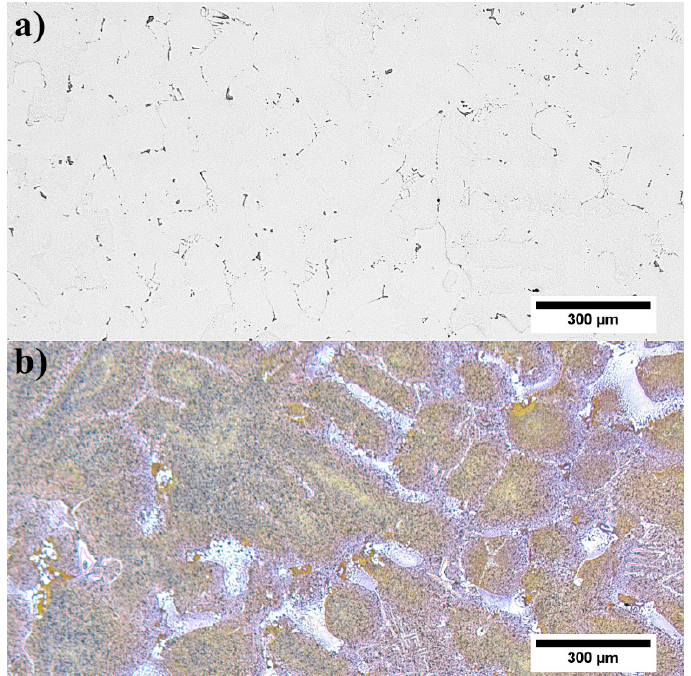
Figure 2. Microstructure of René 108: a ) unetched; b ) etched, light microscopy (LM).